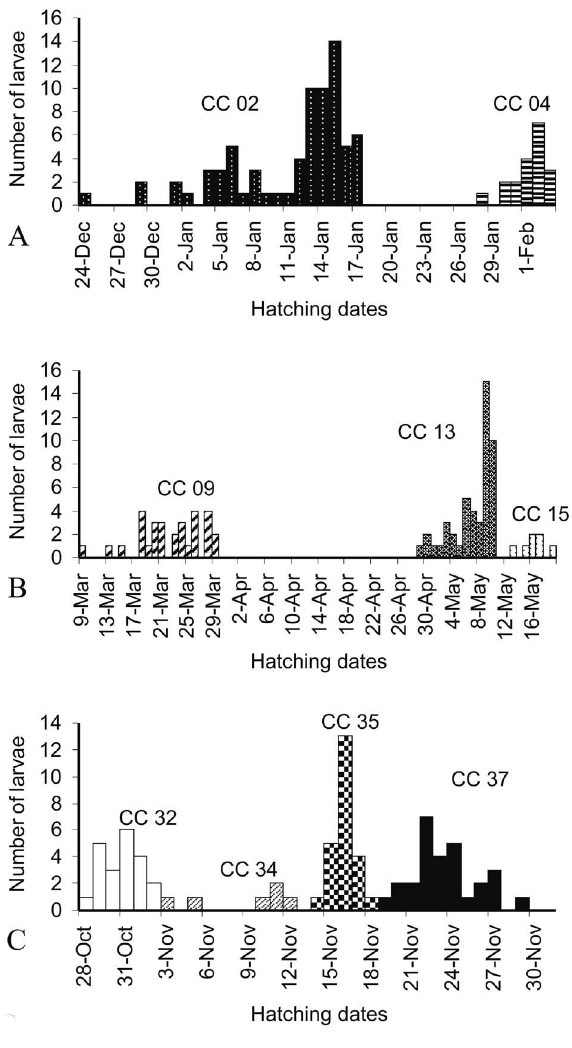
Fig . 2. – Hatching dates for different seasons: A. summer, B. au- tumn and C. spring (CC: cruise